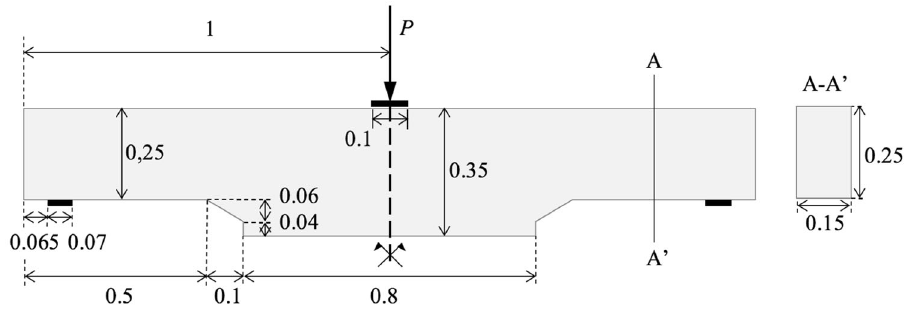
Fig. 2 Geometry of the RC beam (dimensions in m).